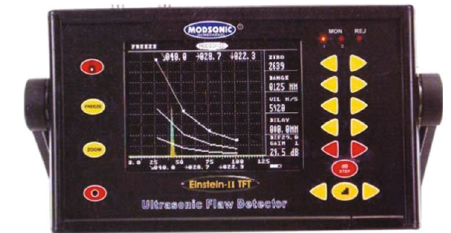
Figure 2: Ultrasonic fl aw detector.